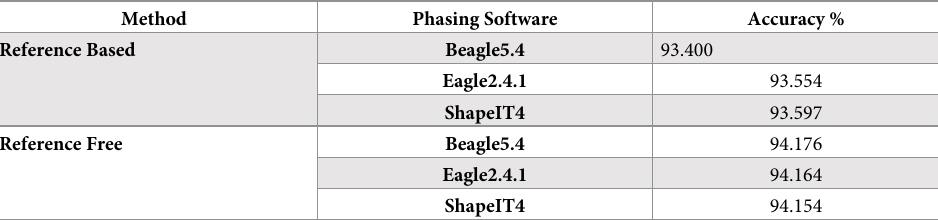
Table 2. Reference-free and reference-based phasing accuracy based on 502,377